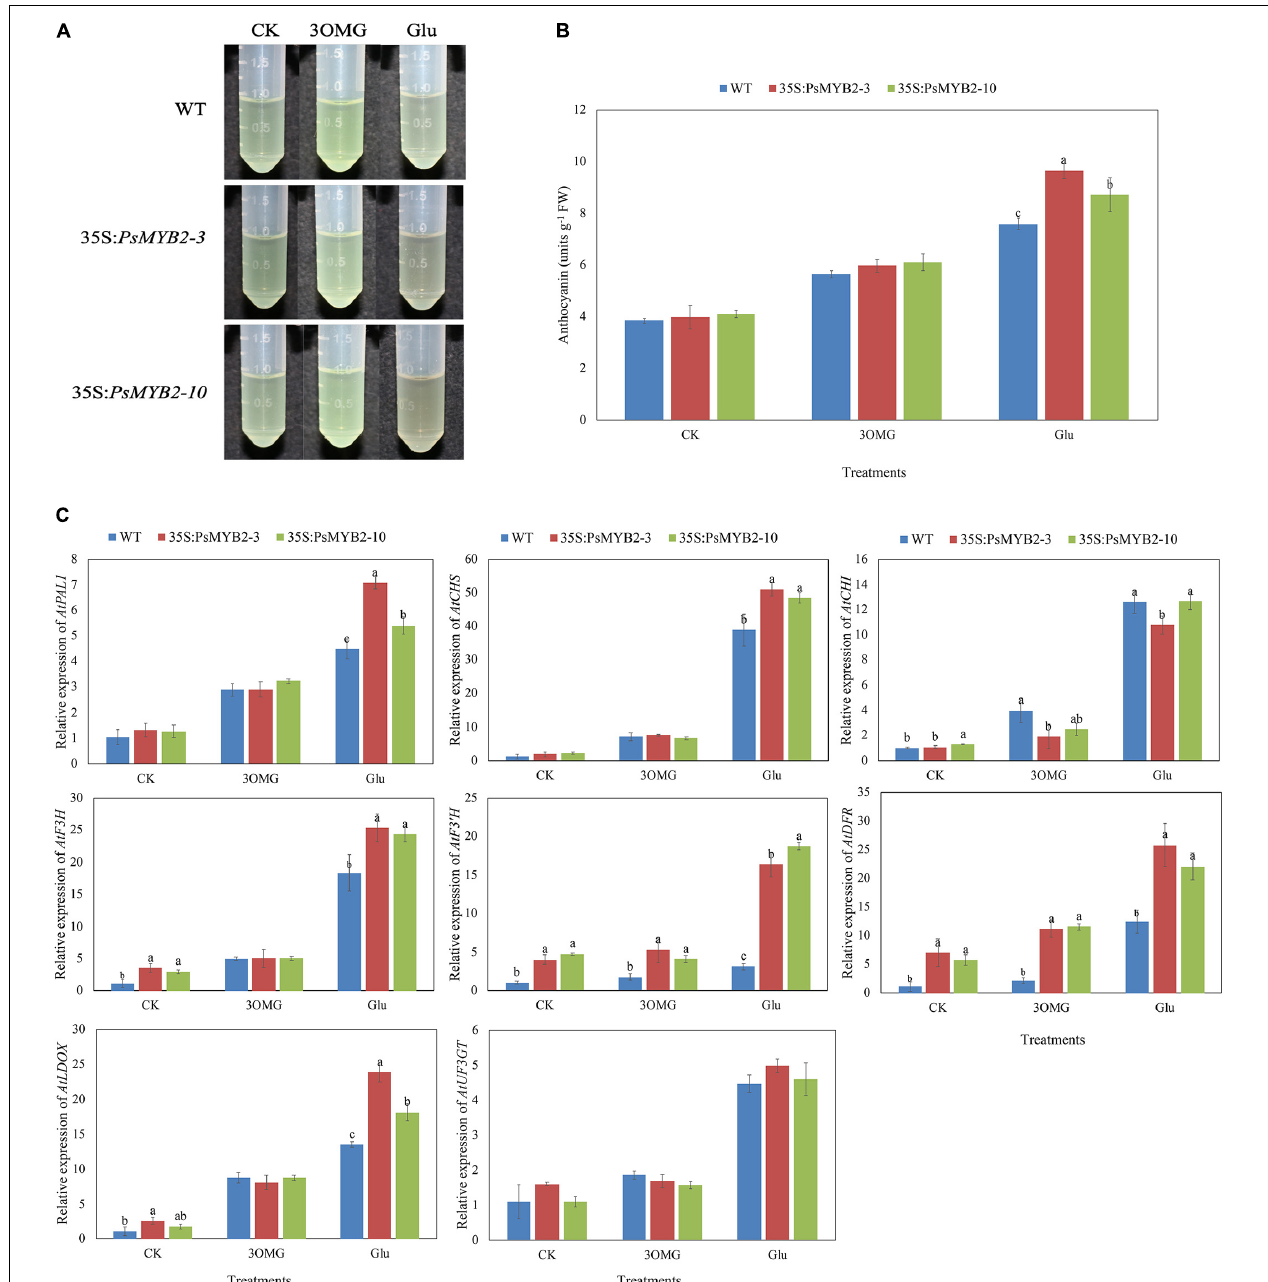
FIGURE 8 | Overexpression of PsMYB2 increased the ability of glucose-induced anthocyanin accumulation in Arabidopsis . (A) Anthocyanin extraction solutions for Arabidopsis seedlings under three treatments. (B) Total anthocyanin content in Arabidopsis seedlings under three treatments. (C) The relative expression levels of anthocyanin biosynthetic pathway genes in Arabidopsis under three treatments. Different small letters indicated significant differences among PsMYB2 transgenic lines and wild-type plants according to Duncan’s multiple range test at p < 0.05. WT, wild-type plant; 35S: PsMYB2 (3 and 10), plant overexpressing PsMYB2